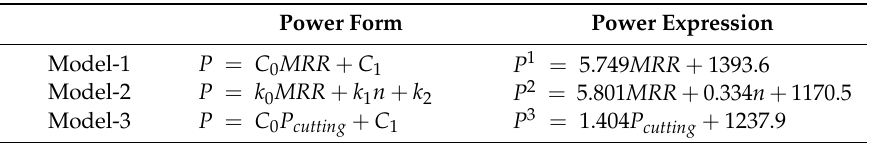
Table 4. Three comparison models.